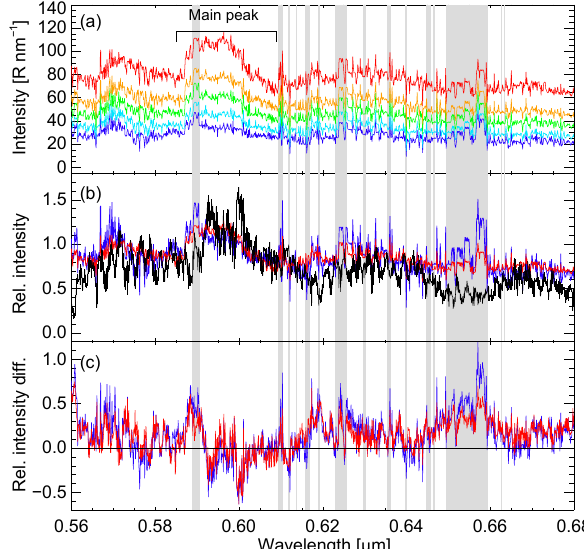
Figure 3. (a) Displays the five median spectra. (b) Illustrates the highest and the lowest quintile median spectra from (a) as well as the theoretical spectrum from Gattinger et al. (2011) in black (see Sect. 3.1.1), with the average main peak emission normalised to one. (c) Displays the deviation of the two selected median spectra from the theoretical spectrum by subtracting the theoretical spec- trum from the median spectra. The colours of the quintile spectra range from blue (median spectrum of the lowest intensity spectra) to red (median spectrum of the highest intensity spectra).